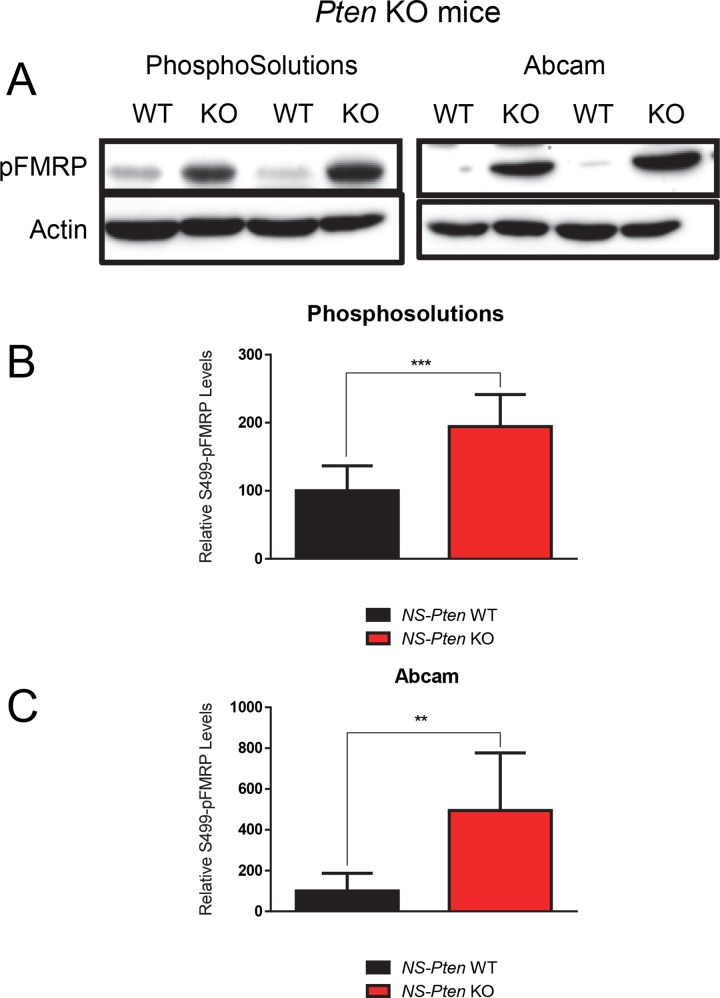

NS-Pten KO leads to increased expression of S499-Phosphorylated FMRP.(Fig 2A) S499-phosphorylated FMRP expression indicated by the antibody from PhosphoSolutions® and abcam® for NS-Pten wildtype (WT) and knockout (KO) mice. The figures are representative blots from WT and KO hippocampal samples probed for the respective antibodies. (Fig 2B) S499-phosphorylated FMRP expression indicated by the Phosphosolutions® antibody. (Fig 2C) S499-phosphorylated FMRP expression indicated by abcam®’s antibody NS-Pten for WT and KO mice. Graphs show the mean (± SEM). n = 9 per group. ** = p < 0.01; *** = p < 0.001.